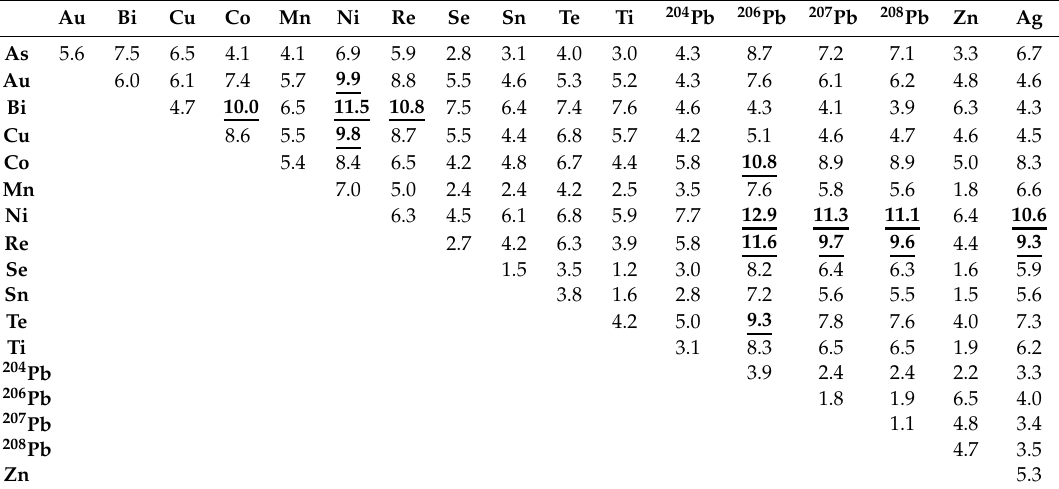
Table 3. Variation matrix for the N = 1501 dataset with entries as the variances of log-ratios for each element pair. The underscored values indicate the weakest column-wise co-dependence.